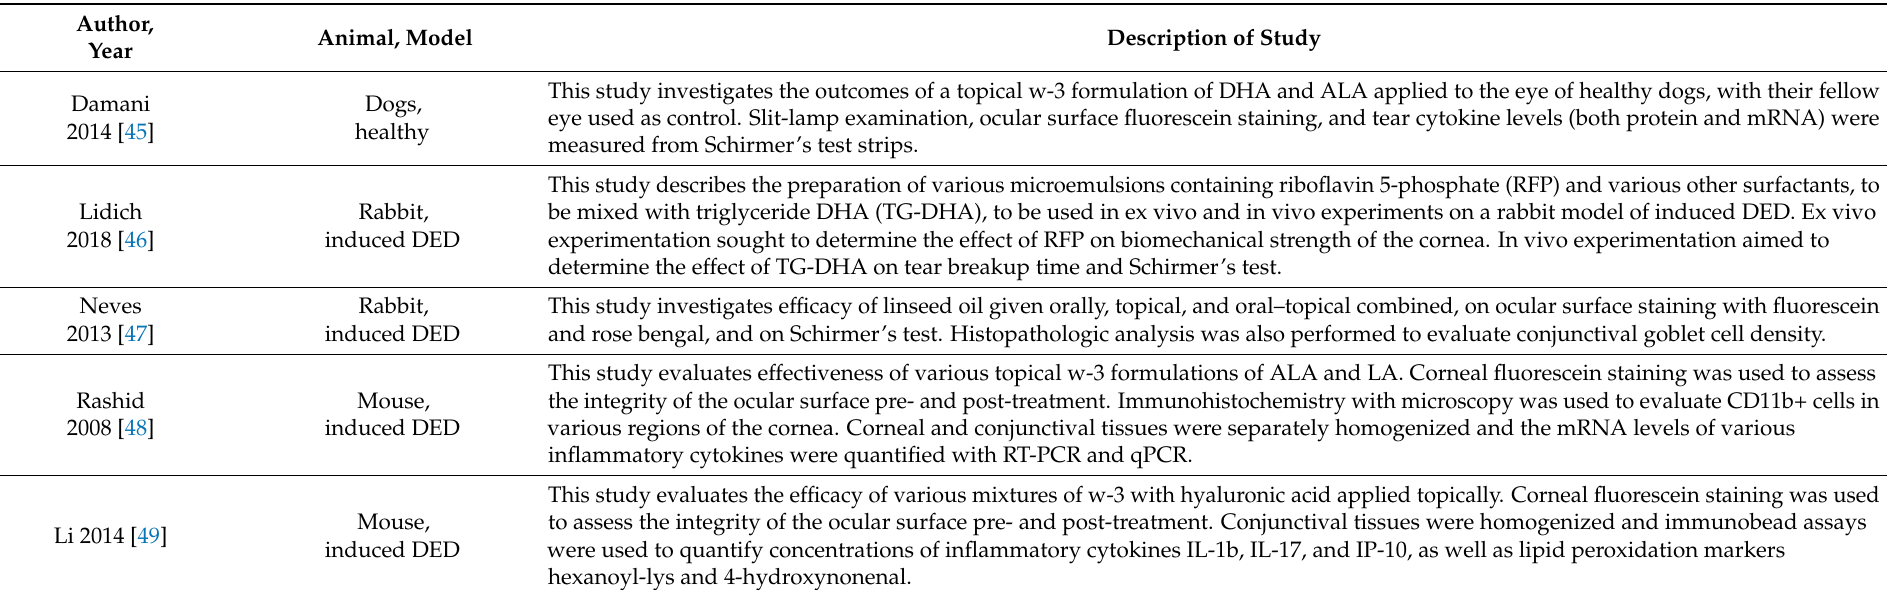
Table 2. Summary of animal